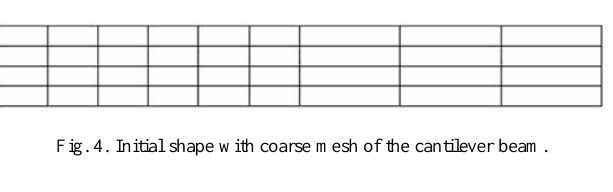
Fig. 3. Step loading applied at the free end of the cantilever.